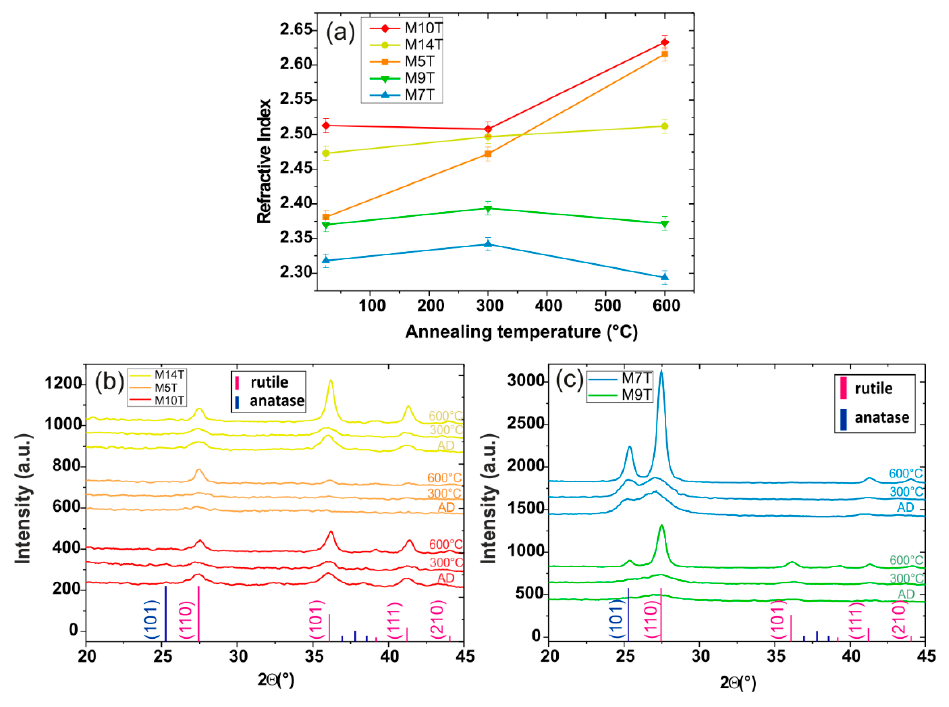
Figure 4. ( a ) Evolution of the films’ refractive index with the annealing temperature. ( b , c ) XRD pat- terns for the as-deposited (AD) and annealed samples with thick TiO 2